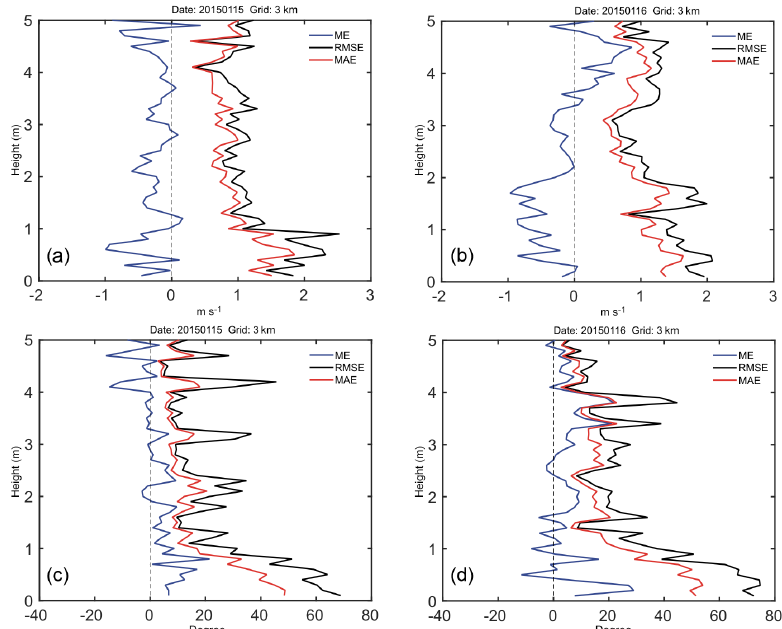
Figure 6. Vertical profiles of mean horizontal wind velocity errors (a, b) and direction (c, d) averaged from the WMO radiosonde sites available across the 3km domain, with the mean absolute error (in red), the root mean square error (in black), and the mean error (in blue). Only measurements from 00:00UTC radiosondes were used in the